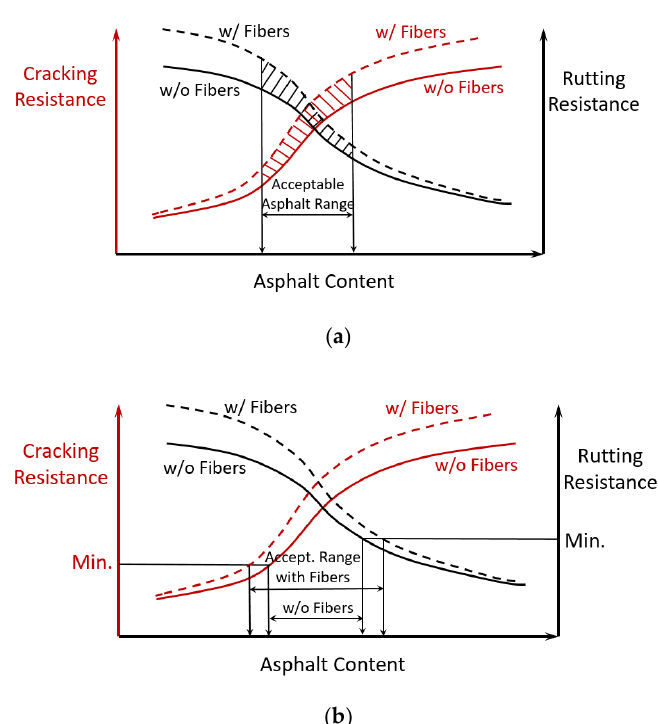
Figure 10. Conceptual effect of fibers on BMD: ( a ) improving cracking and rutting resistance, and ( b ) increasing the acceptable range of asphalt content.